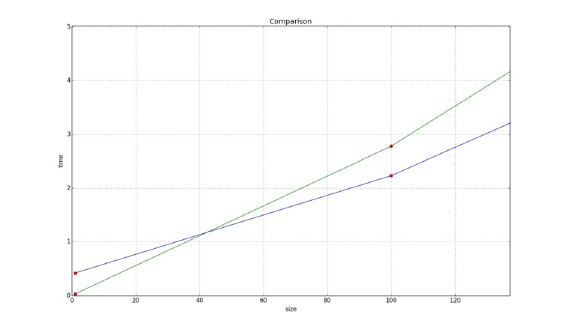
Figure 4. Comparison of calculation results with small amount of data